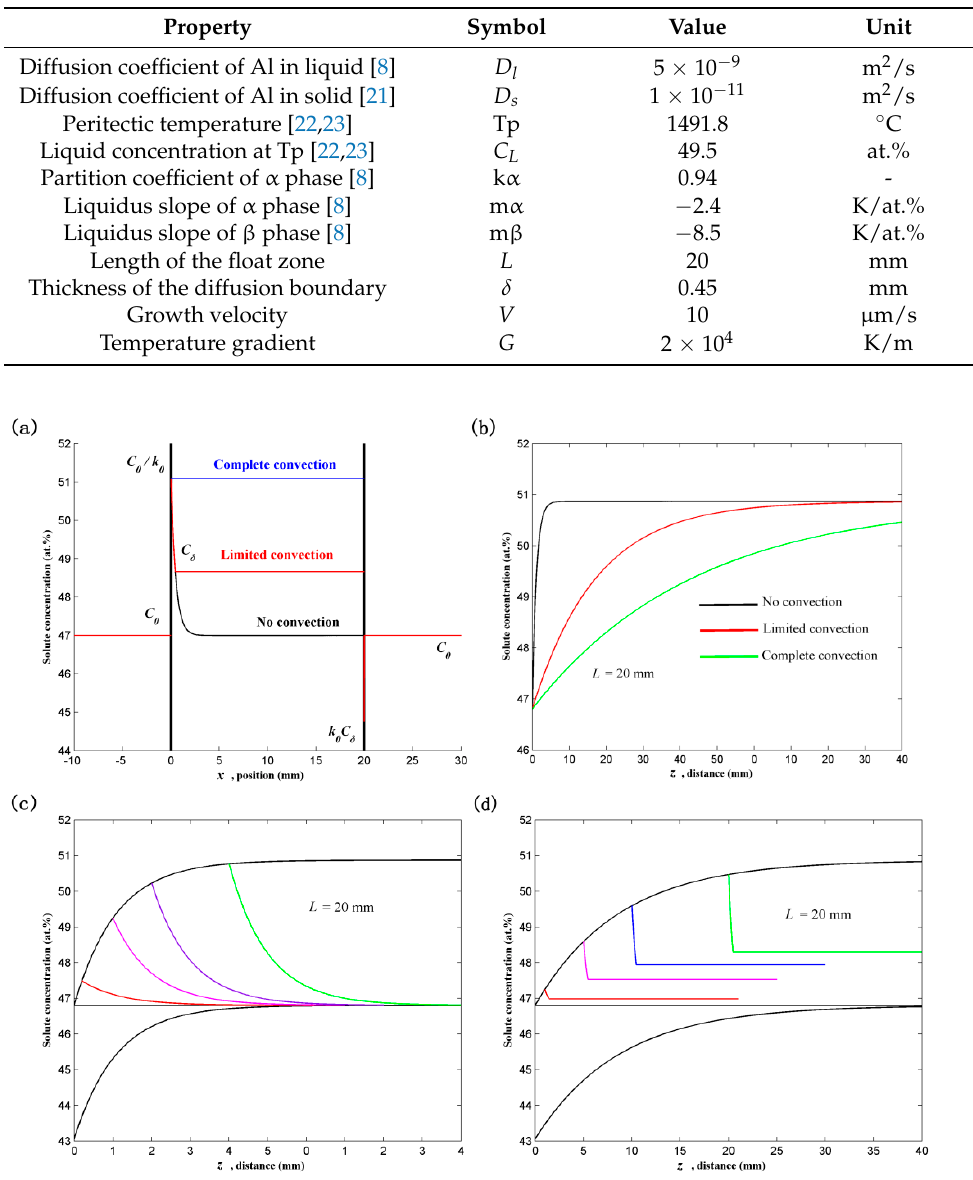
Figure 3. Solute distributions in the steady state ( a ), interface concentrations during the quasi-seeding process with different convections in the float zone ( b ) and the solute redistributions in the initial transient when there is no convection ( c ) and limited convection ( d ) in the float